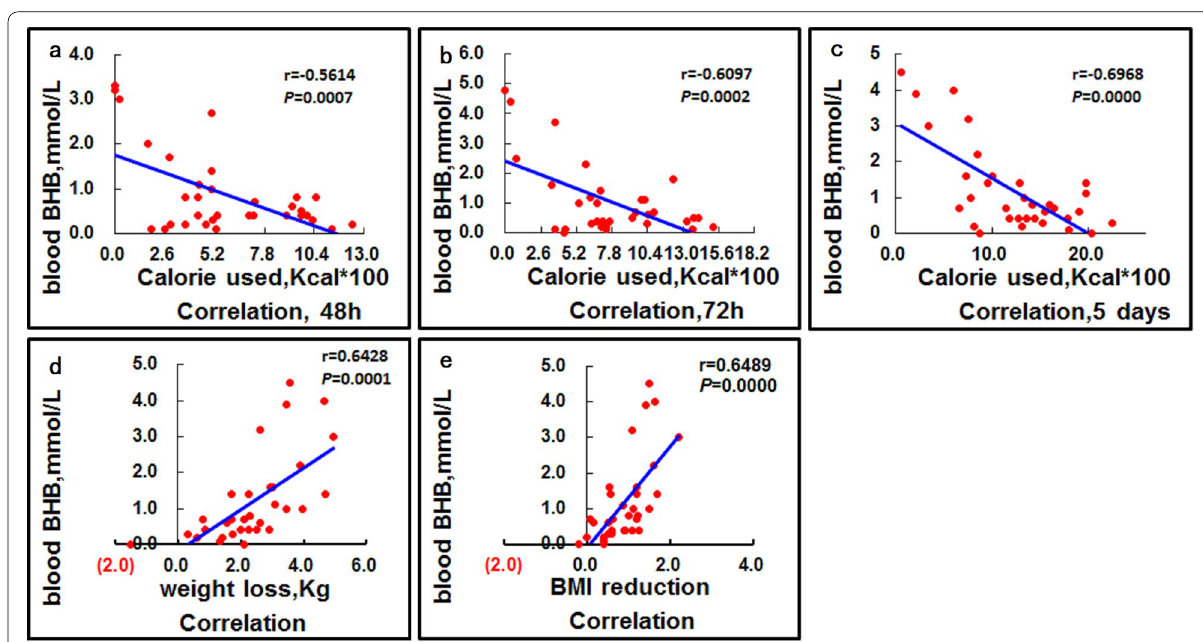
Fig. 1 a-c Calorie consumption was negatively related with blood BHB level at 48 h ( a ), 72 h ( b ), and 5 days ( c ) after the start of Bigu practice. d Body weight loss was positively related with blood BHB level at five days after the start of Bigu practice. e Body mass index was positively related with blood BHB level at five days after the start of Bigu